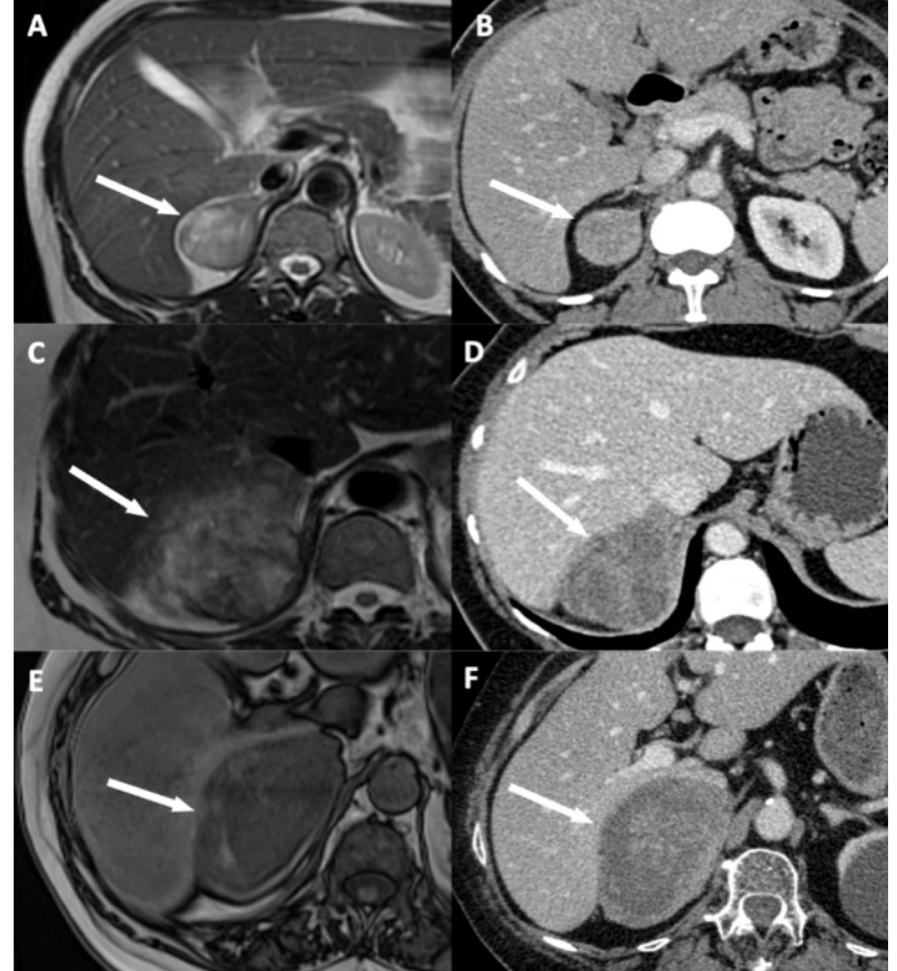
Figure 3. Illustration of disappearance of fat border between adrenocortical carcinoma (ACC) and liver. ( A , B ) A 53-year-old woman with a right-sided cortisol-secreting ACC (Weiss score = 3, Ki67 =